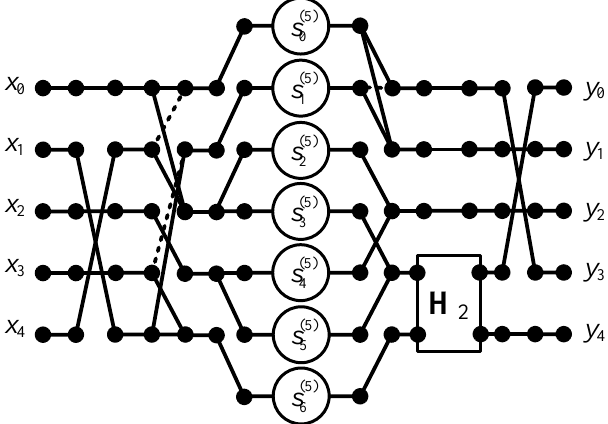
Figure 4. Signal flow graph of the algorithm for computing the 5-point